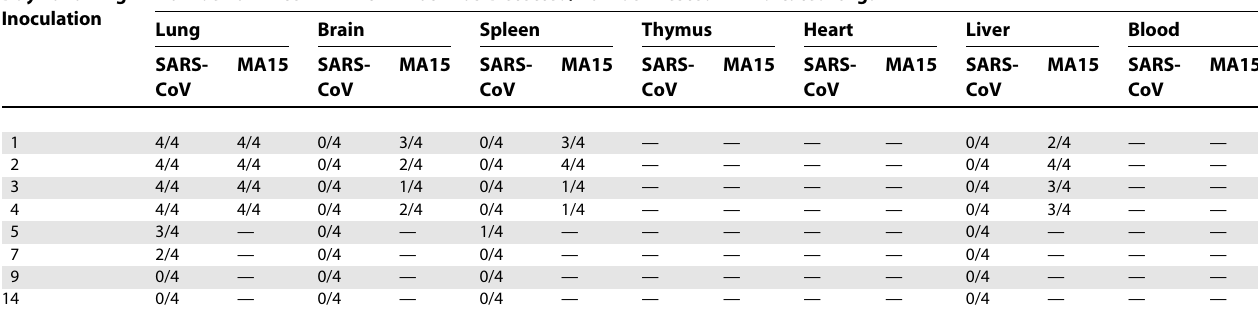
Table 3. Detection of SARS-CoV and MA15 Infectious Virus Day following Number of Mice in Which Virus Was Detected/Number Tested in Indicated Organ Inoculation Lung Brain Spleen